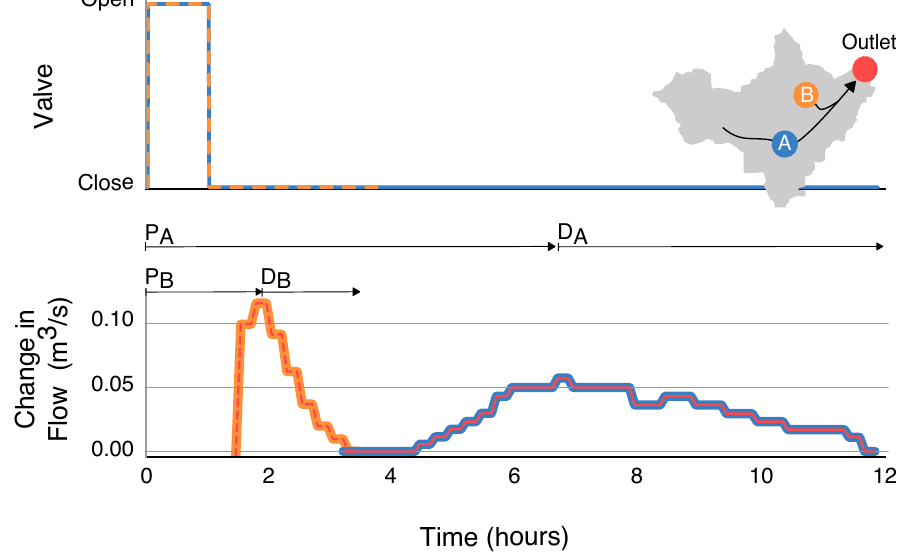
Figure 6. Flows at outlet of watershed resulting from 1 h releases from each control site. Time to peak P , magnitude, and decay time D for each release are labeled.